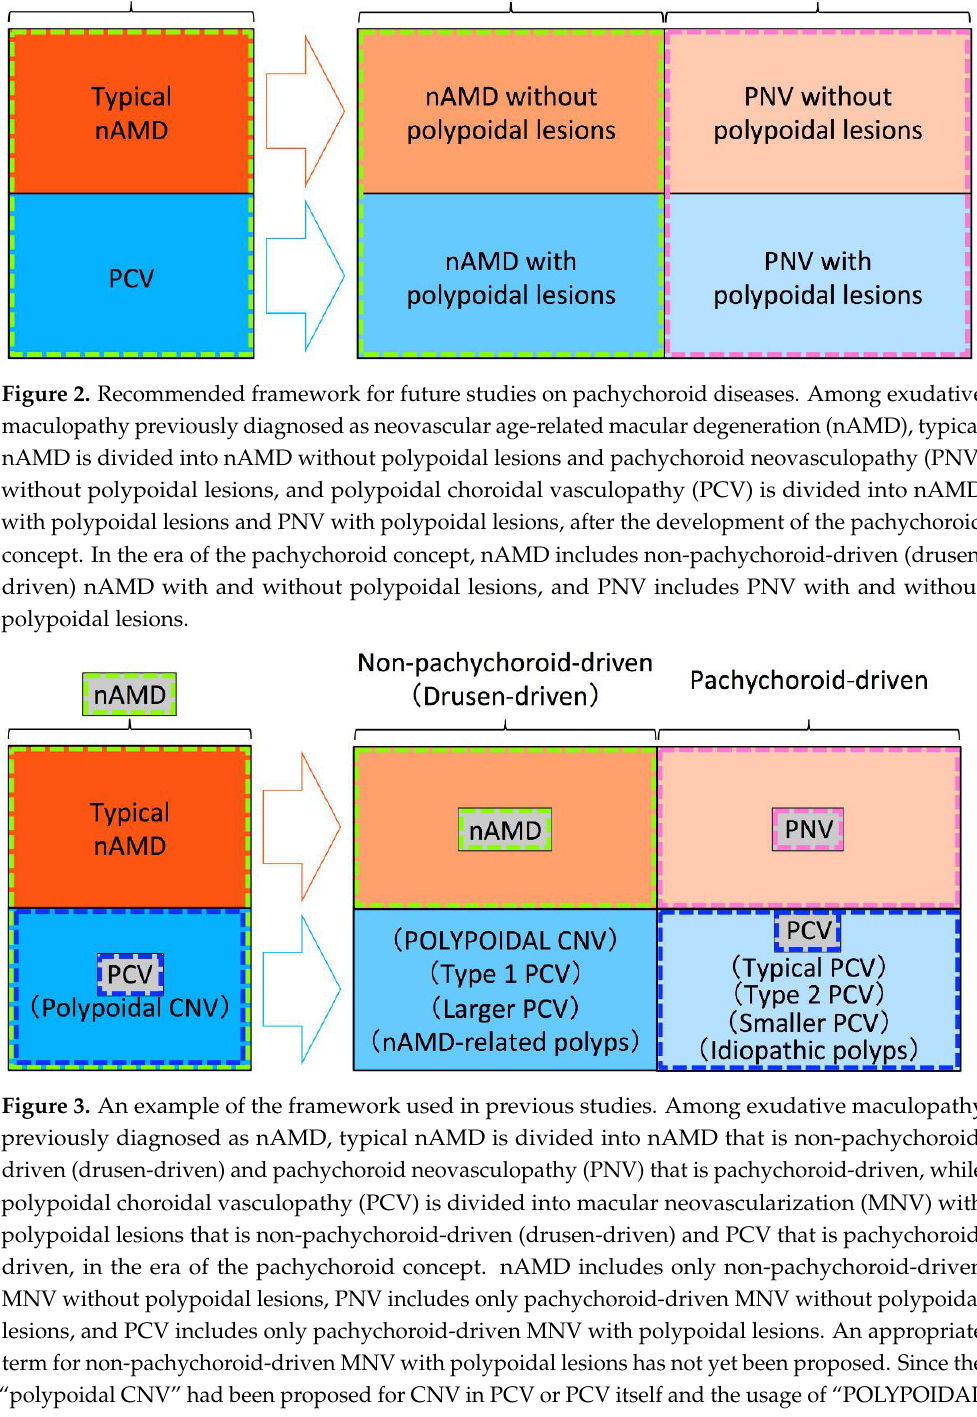
Figure 4. An example of a framework used in previous studies. Among exudative maculopathy previously diagnosed as nAMD, typical nAMD is divided into typical nAMD that is non-pachychoroid-driven (drusen-driven) and typical pachychoroid neovasculopathy (PNV) that is pachychoroid-driven, and polypoidal choroidal vasculopathy (PCV) is divided into non-pachychoroid-driven (drusen-driven) macular neovascularization (MNV) with polypoidal le- sions and pachychoroid-driven MNV with polypoidal lesions, in the era of the pachychoroid con- cept. nAMD includes both non-pachychoroid-driven MNV without and with polypoidal lesions. PNV includes both pachychoroid-driven MNV without and with polypoidal lesions. PCV includes both non-pachychoroid-driven MNV with polypoidal lesions and pachychoroid-driven MNV with polypoidal lesions. Pachychoroid-driven MNV with polypoidal lesions should be called typical PCV and an appropriate term for non-pachychoroid-driven MNV with polypoidal lesions has not yet been proposed. Since the “polypoidal CNV” had been proposed for CNV in PCV or PCV itself and the usage of “POLYPOIDAL CNV” by Yuzawa et al. differs from the orig inally used term “polypoidal CNV”, “POLYPOIDAL CNV” by Yuzawa et al. is written in uppercase for differenti- ation.